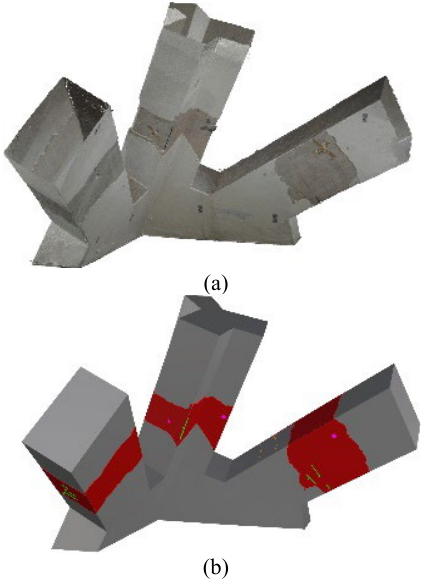
Figure 8. Multi-temporal photogrammetric data on different times.